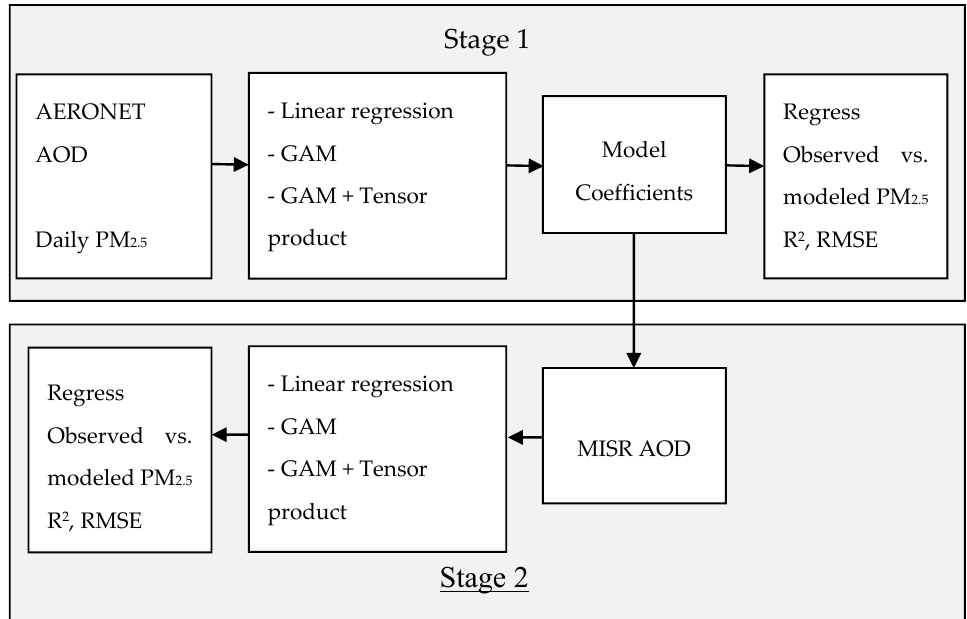
Figure 2. Methodology flowchart for calibration model development. Top: Stage 1—calibration models using only AERONET Aerosol Optical Depth (AOD) and Environmental Protection Agency (EPA) PM2.5 data, Bottom: Stage 2—apply calibration models to convert Multiangle Imaging Spectroradiometer (MISR) AOD to PM2.5 concentrations.